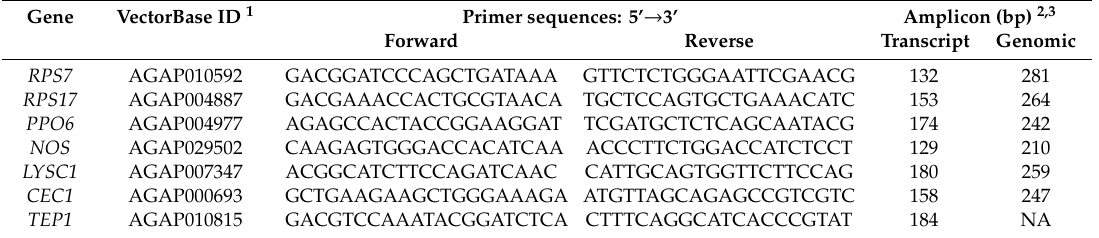
Table 1. Genes assayed by Real-Time PCR (RT-PCR), including gene IDs and primer sequences.